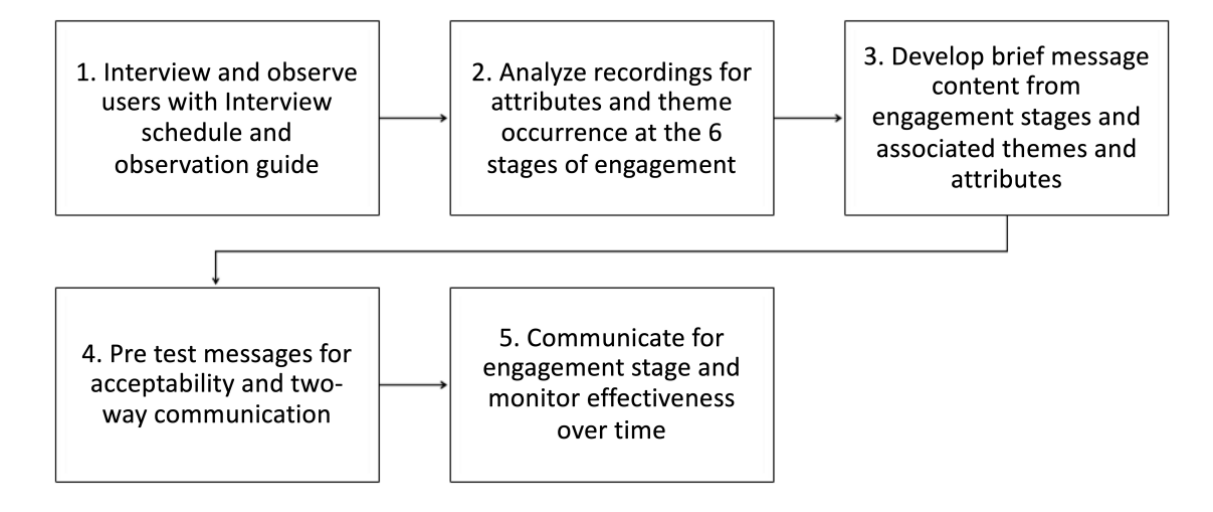
Figure 4. A five-step process to develop effective brief message